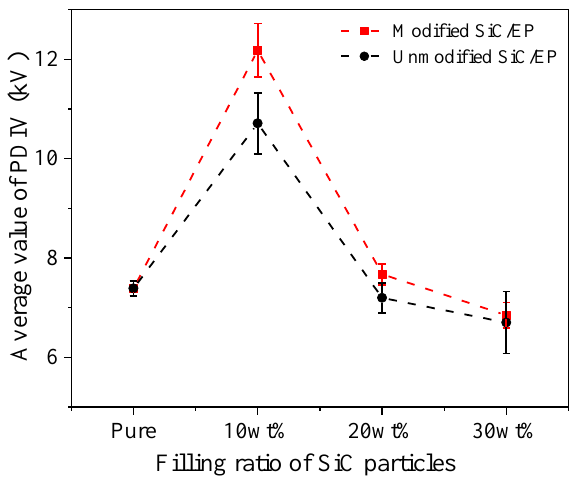
Figure 5. Partial discharge initial voltage of SiC/EP composites.